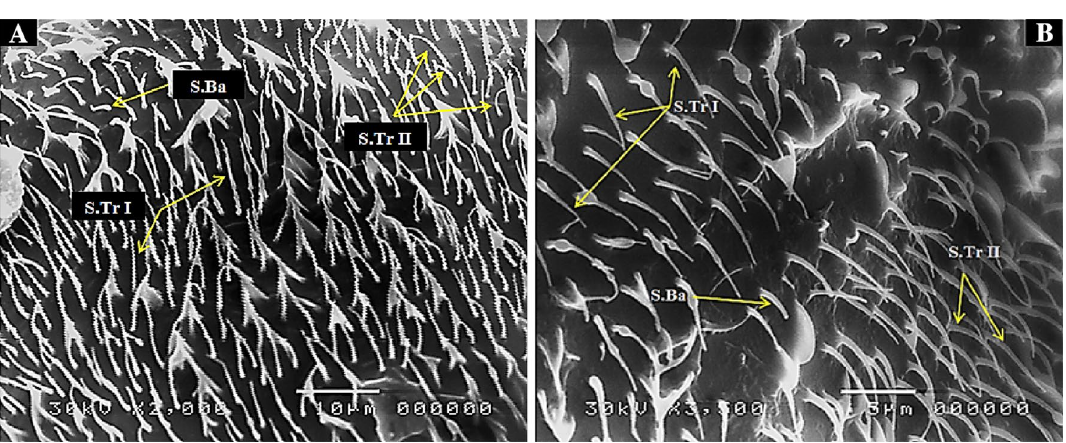
Figure 2. SEM photography of control, Culex pipiens female (2000 and 3500×) ( A , B ) showing clypeus covered heavily with the sensilla trichodea (S.Tr I& S.Tr II) and sensilla basiconica (S.Ba).